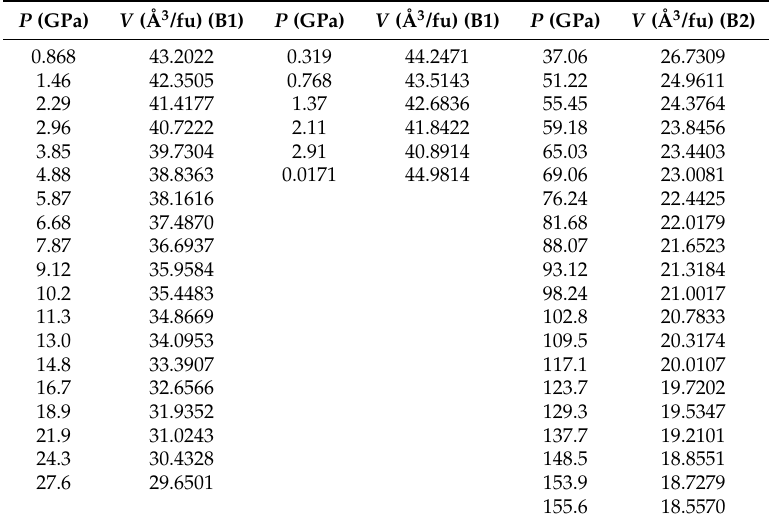
Figure 3. Volume of NaCl measured in this study and in the literature [26–28]. Table 3. Pressure P (from ruby luminescence, with calibration from [4]) and volume V (measured with X-ray diffraction) for NaCl (B1 and B2 phases). Each pair of columns corresponds to one experimental run. The data are listed in the order they have been